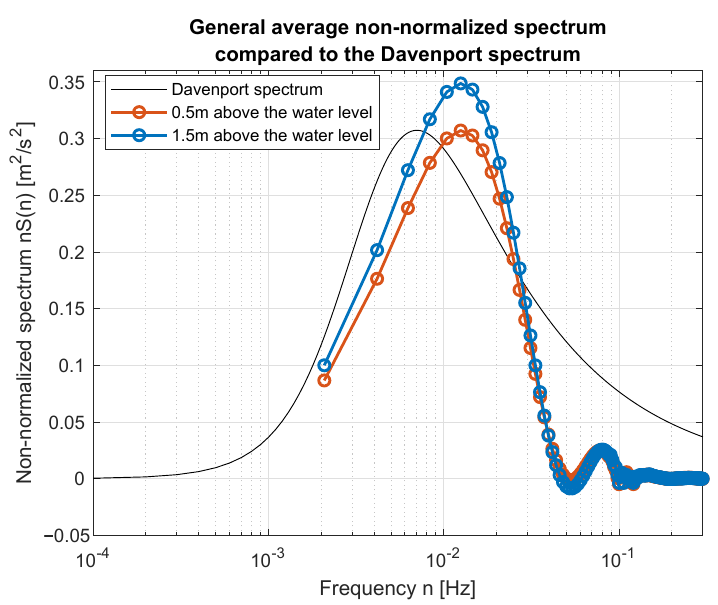
Figure 22. Medium-strong wind (6 BFT in ship scale) compared to Karman spectrum. Quantitative analysis of the computed PSD and standard spectra for each wind force is presented in Table 4. Mean squared error (MSE) was computed as a sum of squared differences between PSD model and PSD computed on the basis of experimental data. Presented in Table 4 MSEs are the best fits to standard spectra, named in the third column. Acceptable fit at 0.05 level was obtained only for two spectra—for wind force 3 and 5 BFT in ship scale. Usage of the other standard spectral models will need their empirical scaling.